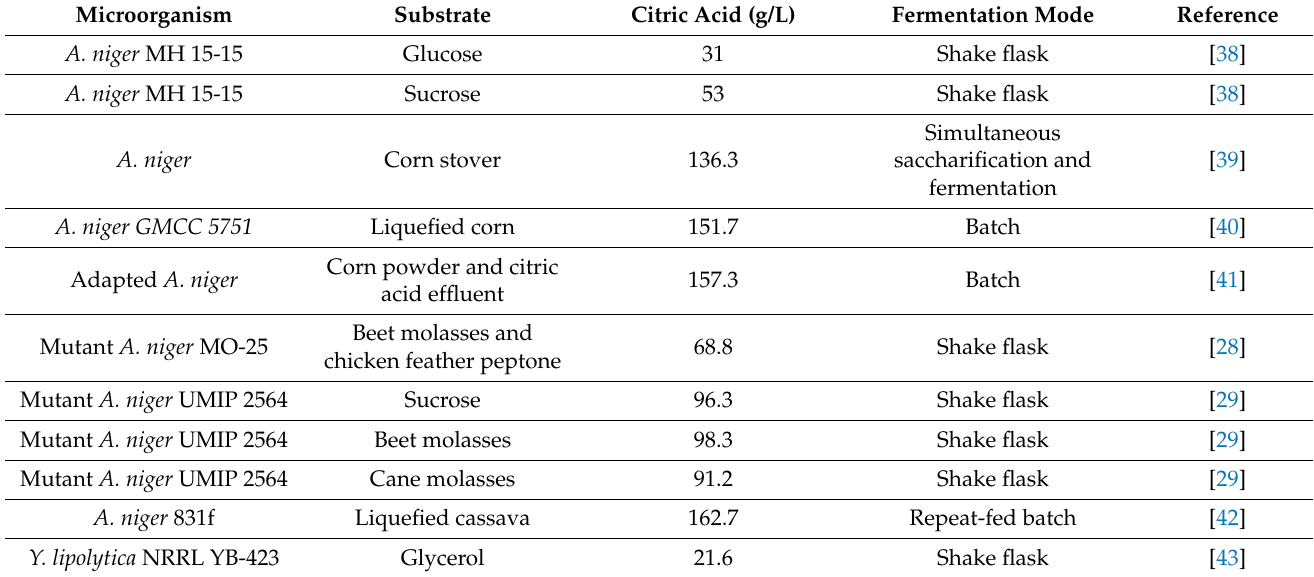
Table 2. Citric acid production with different substrates, microorganisms, and fermentation